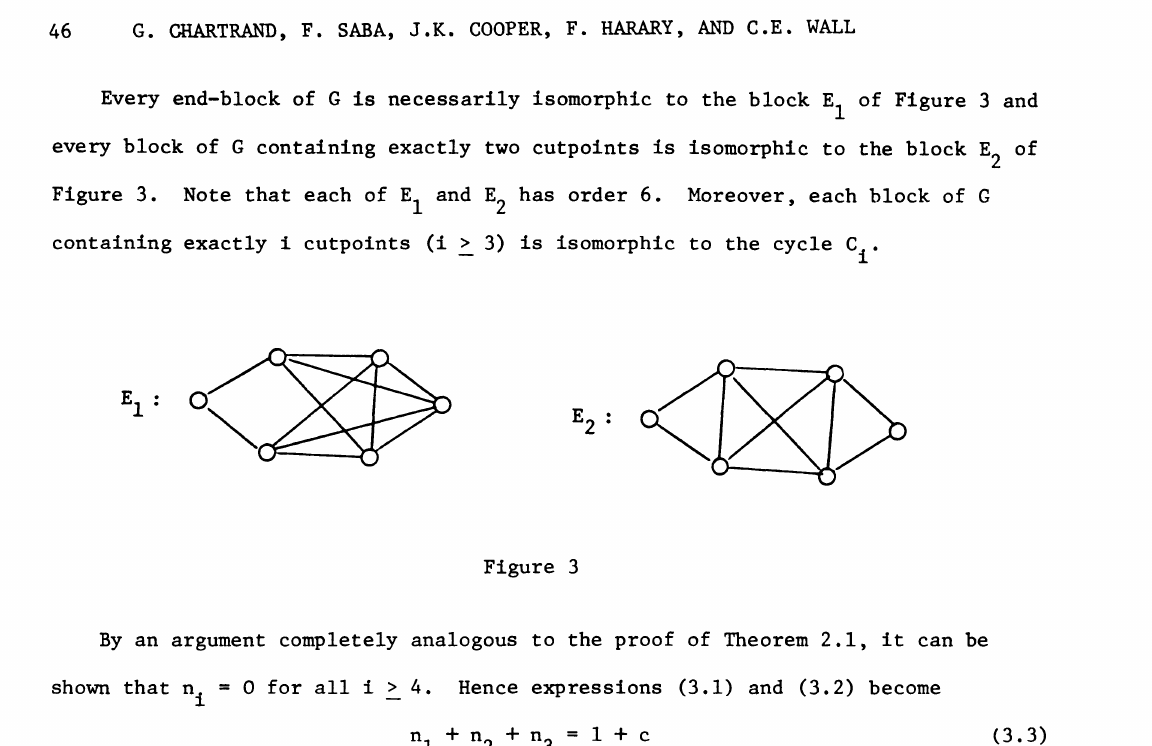
of Figure 3 and 1 of 2